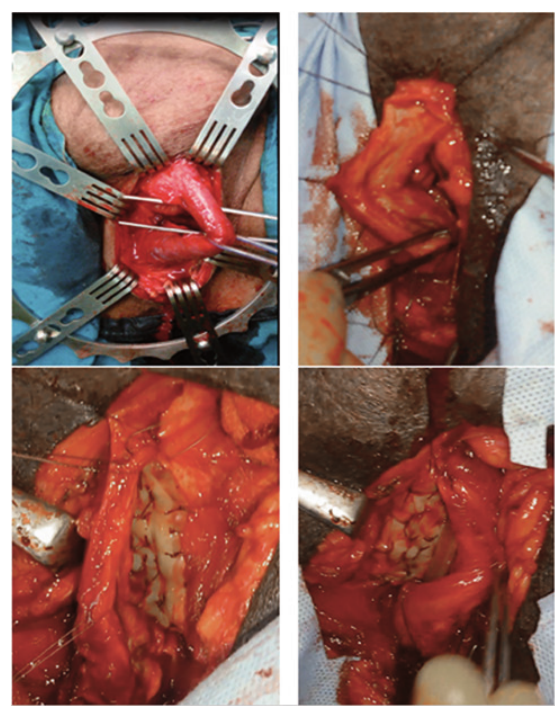
Figure 2 - Dorsal onlay buccal mucosa graft